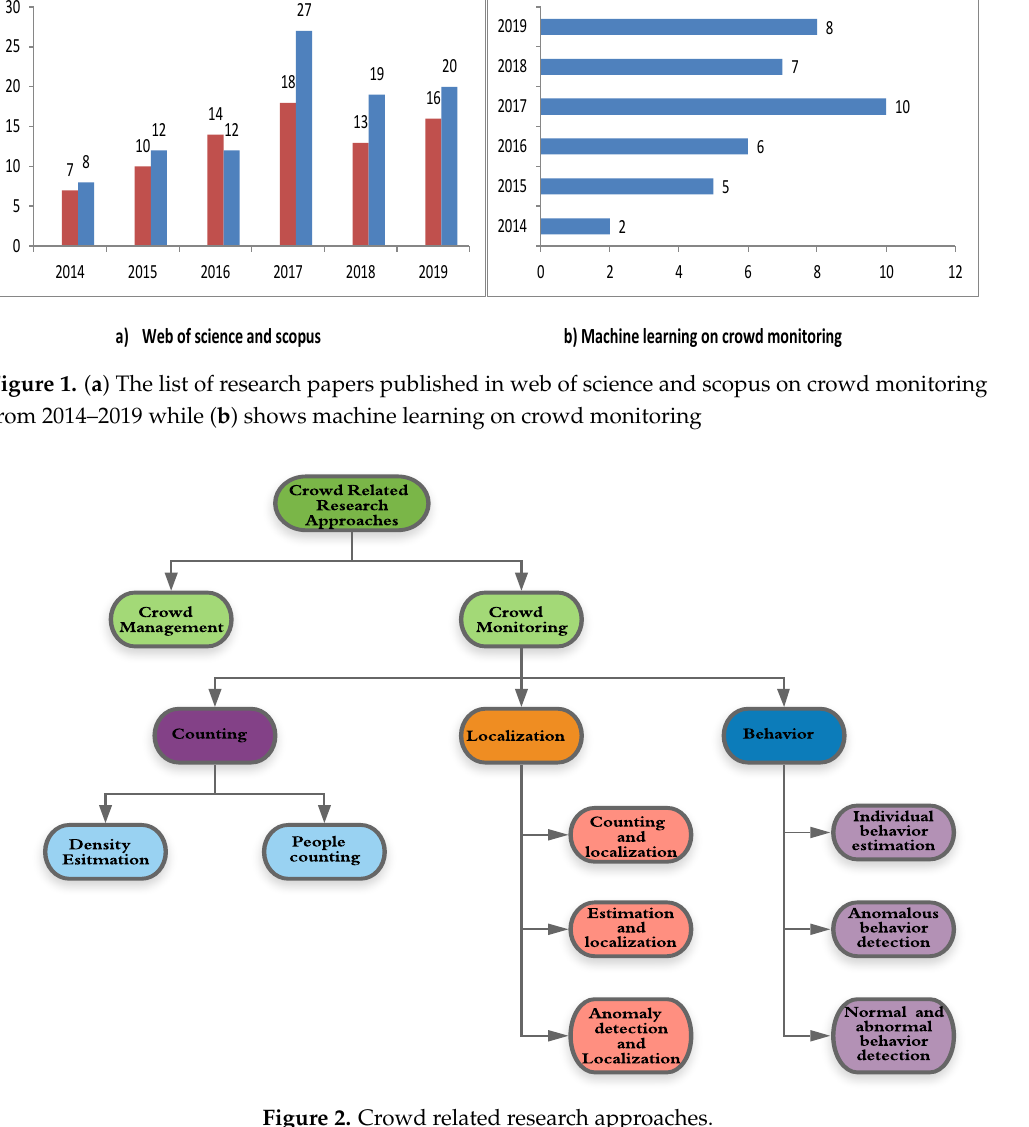
Figure 2. Crowd related research